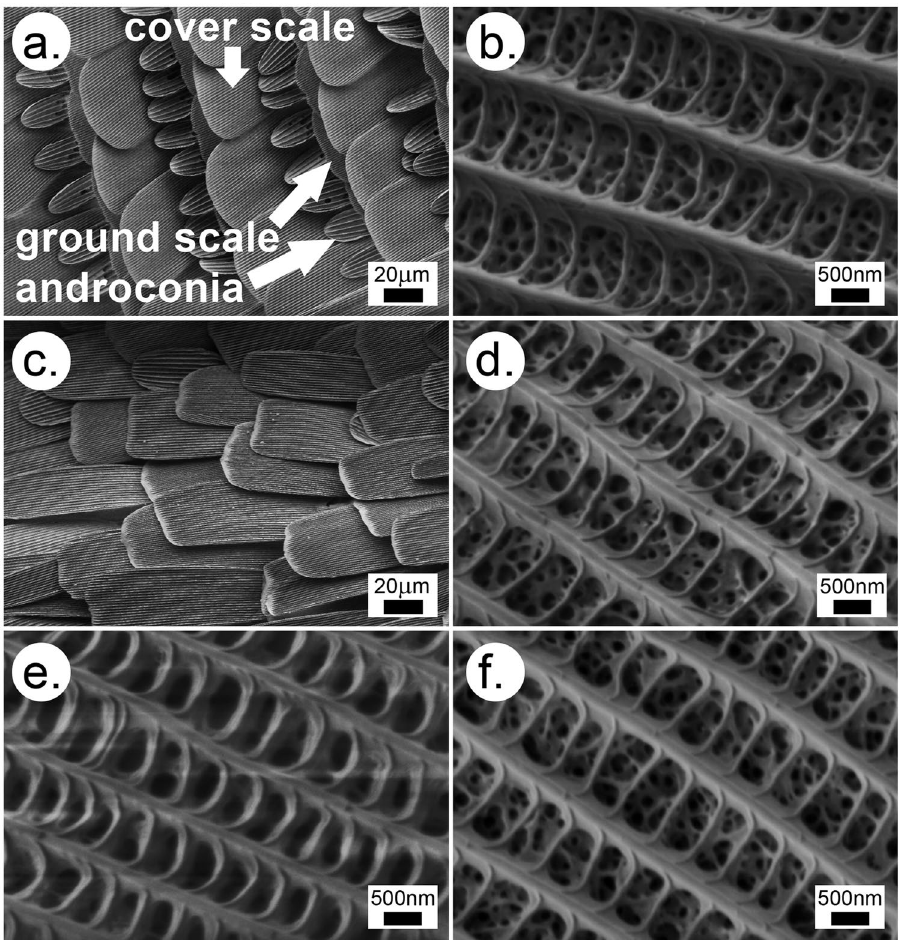
Figure 6. SEM images of the wing scales of the wild male and of the male eclosed from a pupa cooled for 22 days. ( a ) Wild male, overview of the regular rows of scales, the white arrows point to the cover and ground scales and to the androconia ( b ) wild male, pepper-pot structure in the volume of a blue scale, ( c ) cooled male, overview of the disordered scales, ( d ) cooled male, pepper-pot structure in the regular shape blue scale, ( e ) cooled male, black scale, ( f ) cooled male, pepper-pot structure in a narrow blue scale.